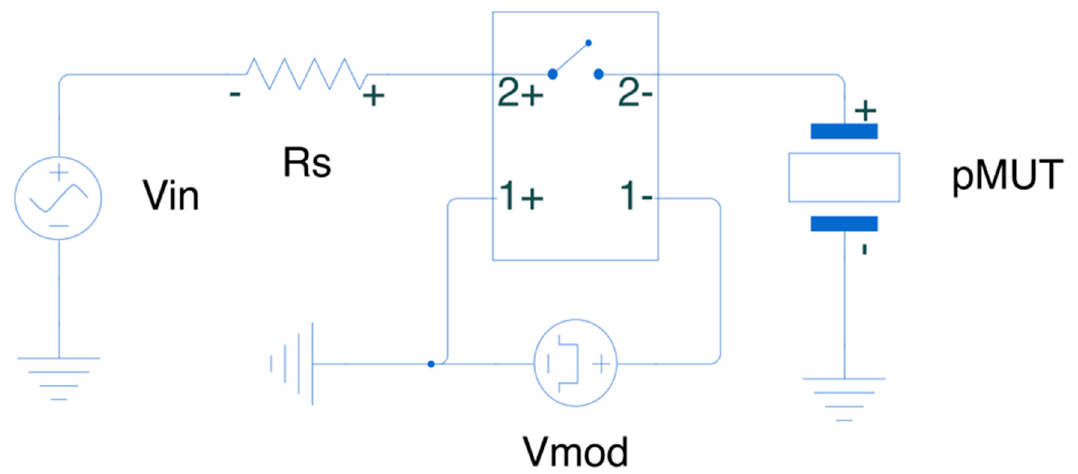
Figure 5. Continuous wave driving of the pMUT array with and ideal switch to implement the ON/OFF keying modula- tion.